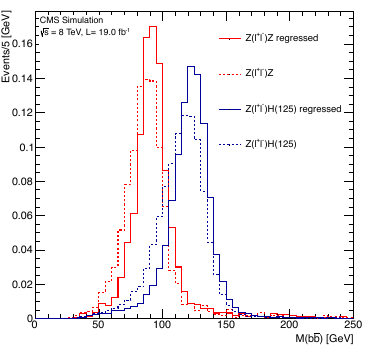
Figure 2. Mass di ↵ erence between ZH and ZZ simulated pro- cessed before and after the regression is applied.